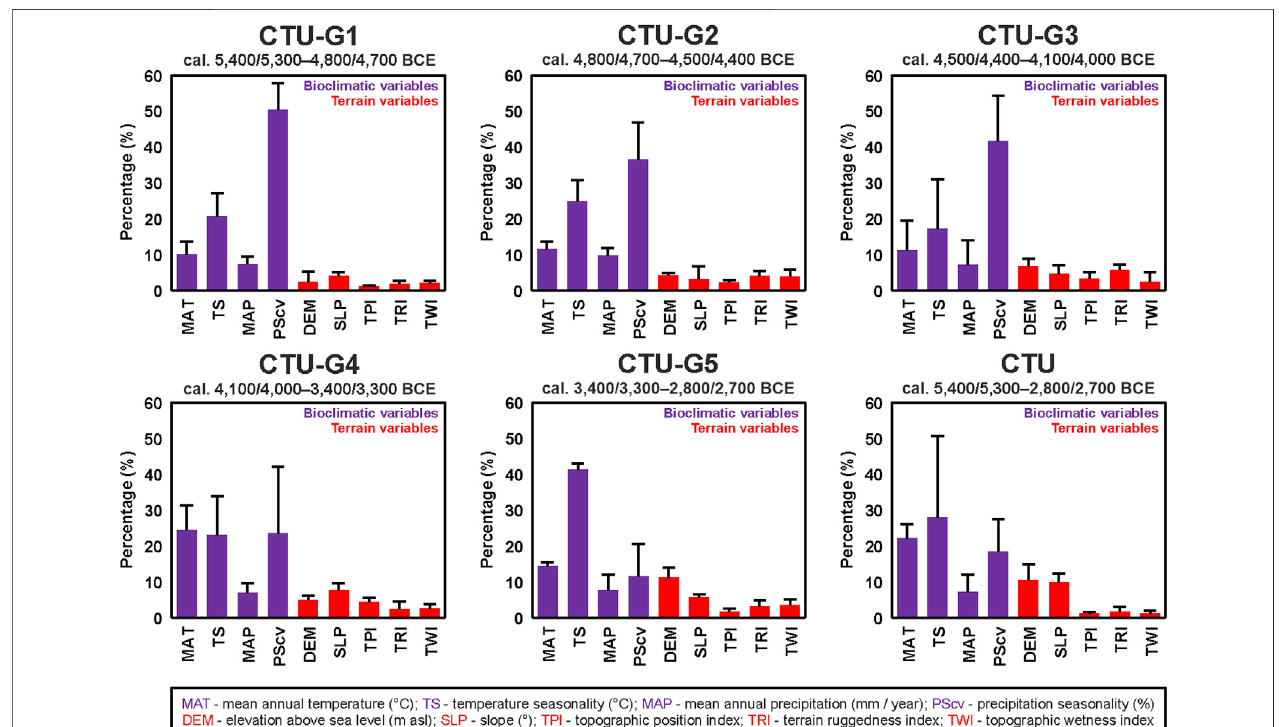
FIGURE8| VariablecontributionstoCTUandCTUgroups ’ nichesreconstructed usingGCM-derivedbioclimaticvariables(see Figure5 )andDEM-derivedterrain variables.